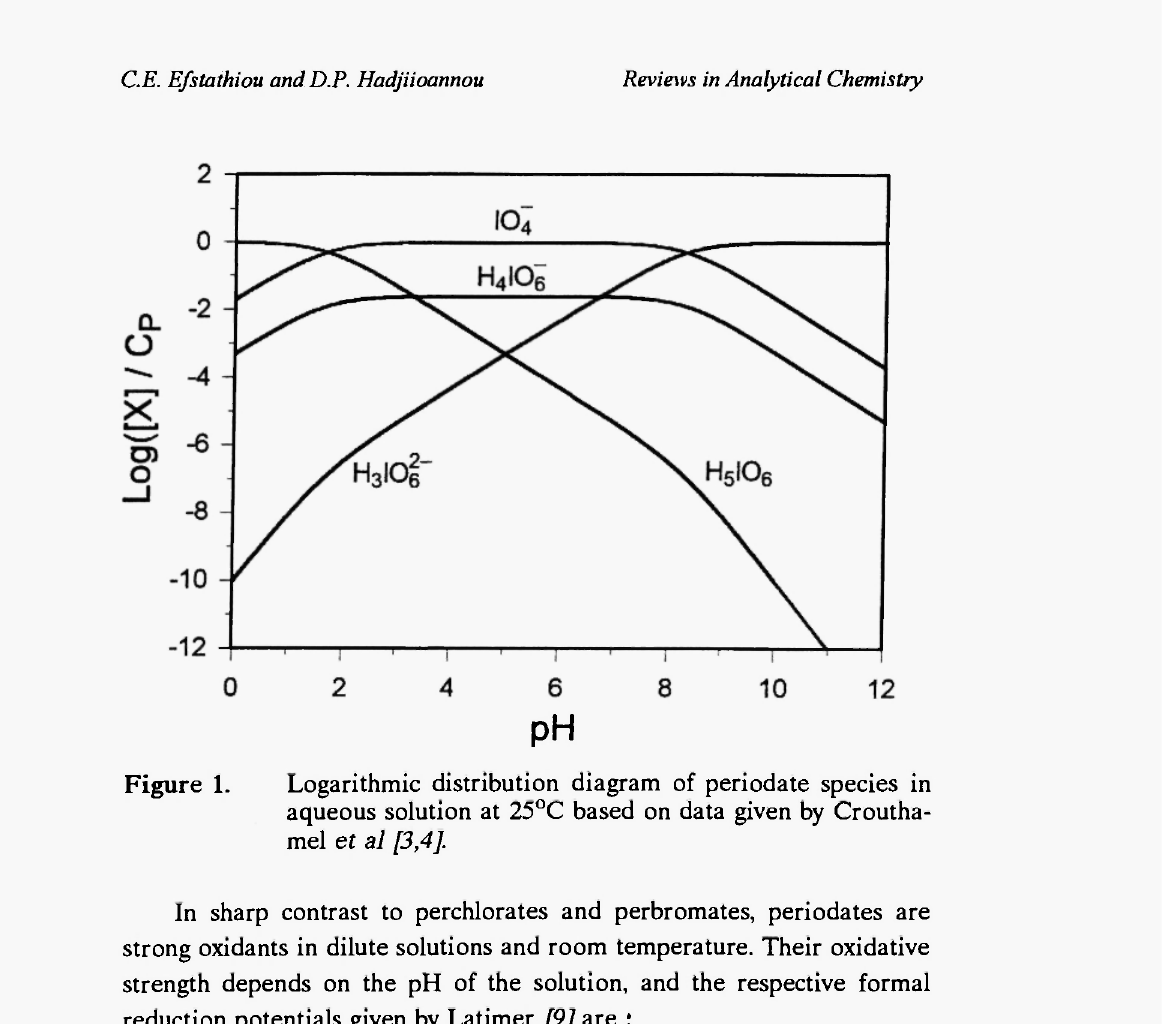
Figure 1. Logarithmic distribution diagram of periodate species in aqueous solution at 25°C based on data given by Croutha- mel et al